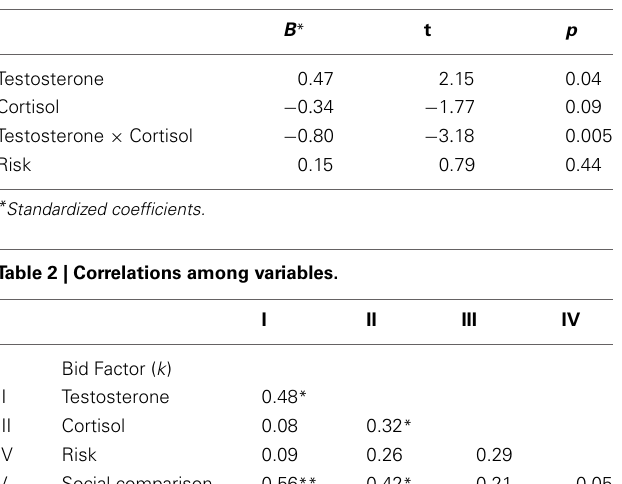
Table 1 | Robust linear regression model predicting overbidding.